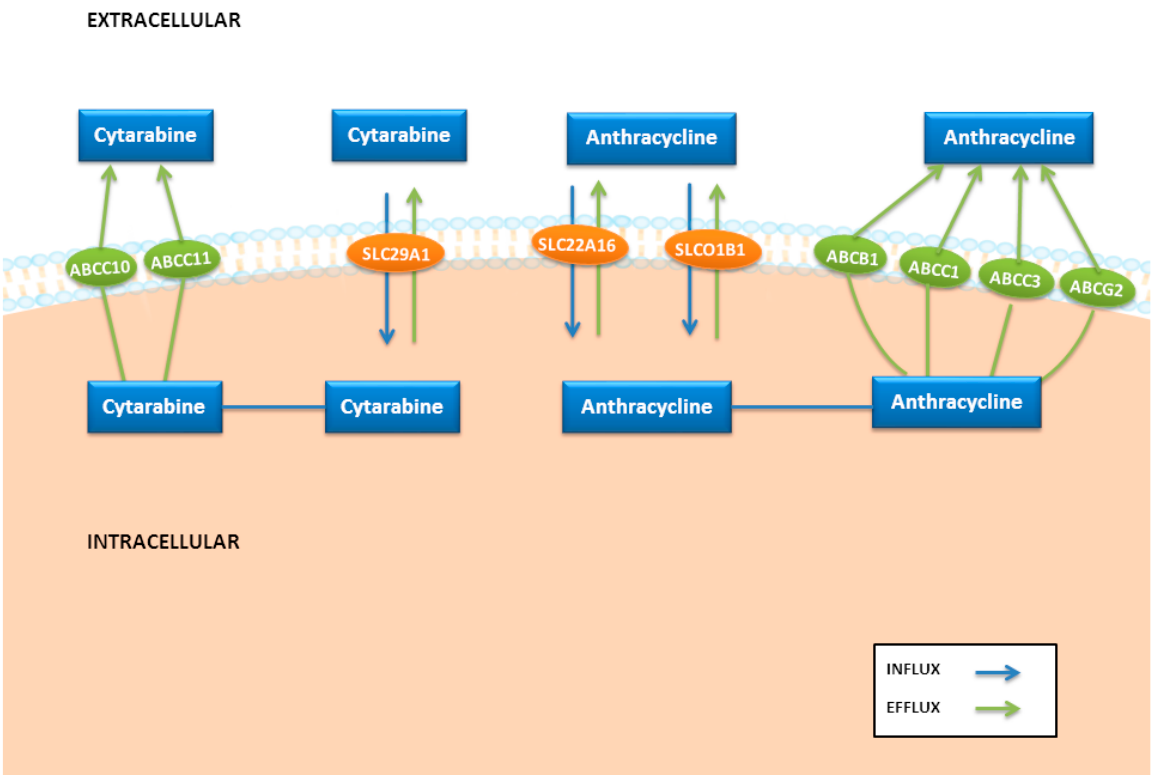
Figure 2. Key candidate genes involved in drug transport in acute myeloid